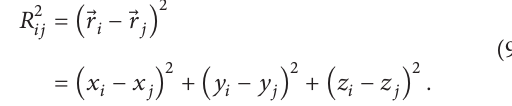
physical model. Based on the NGP scheme, particles in the galaxy object are interpolated onto a mesh, and each particle is approximatively supposed to be located at the closest point in the mesh, as depicted in Figure